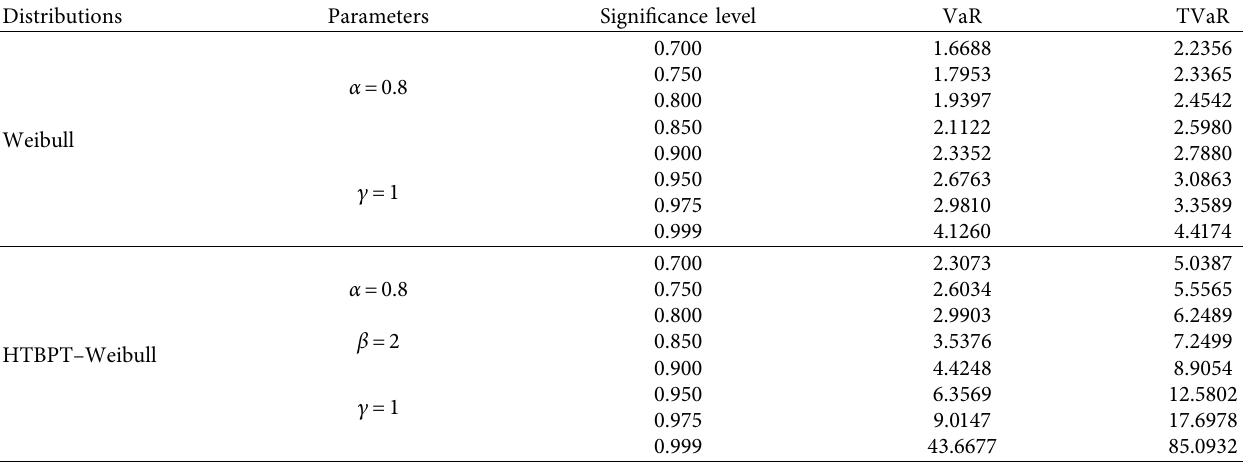
Table 3: For n � 100, the simulation study of the risk measures for Weibull and HTBPT–Weibull distributions.